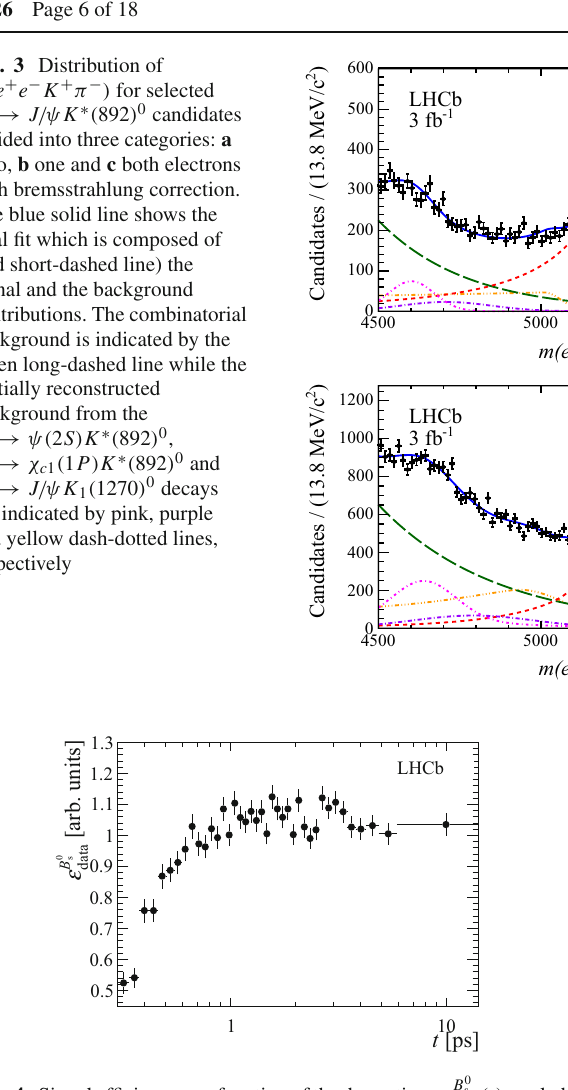
Fig. 4 Signalefficiencyasafunction ofthedecaytime, ε B by the average